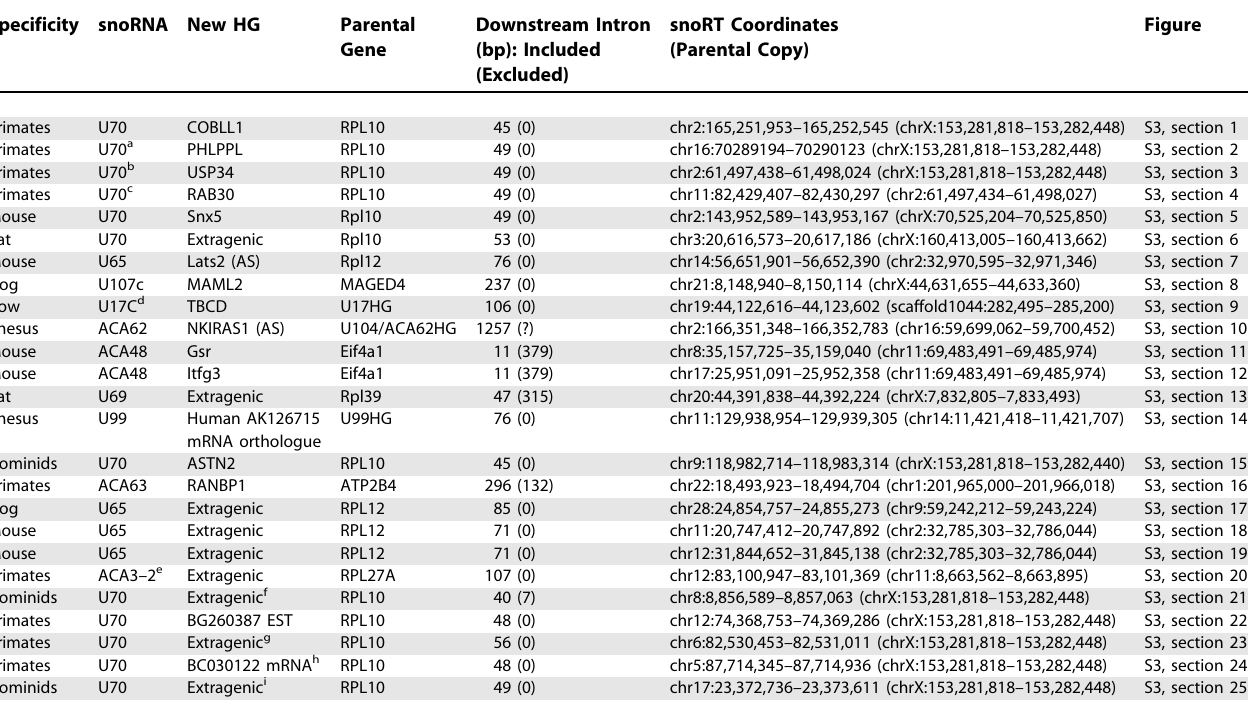
Table 3. Examples of Mammalian Type 3 snoRTs Specificity snoRNA New HG